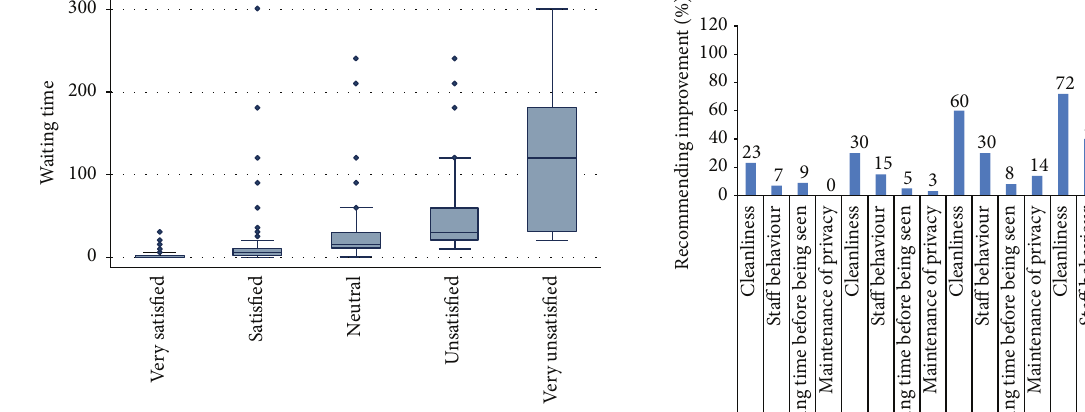
Figure 1: Waiting time (minutes) according to level of satisfaction with waiting time ( 𝑁 = 447 ).